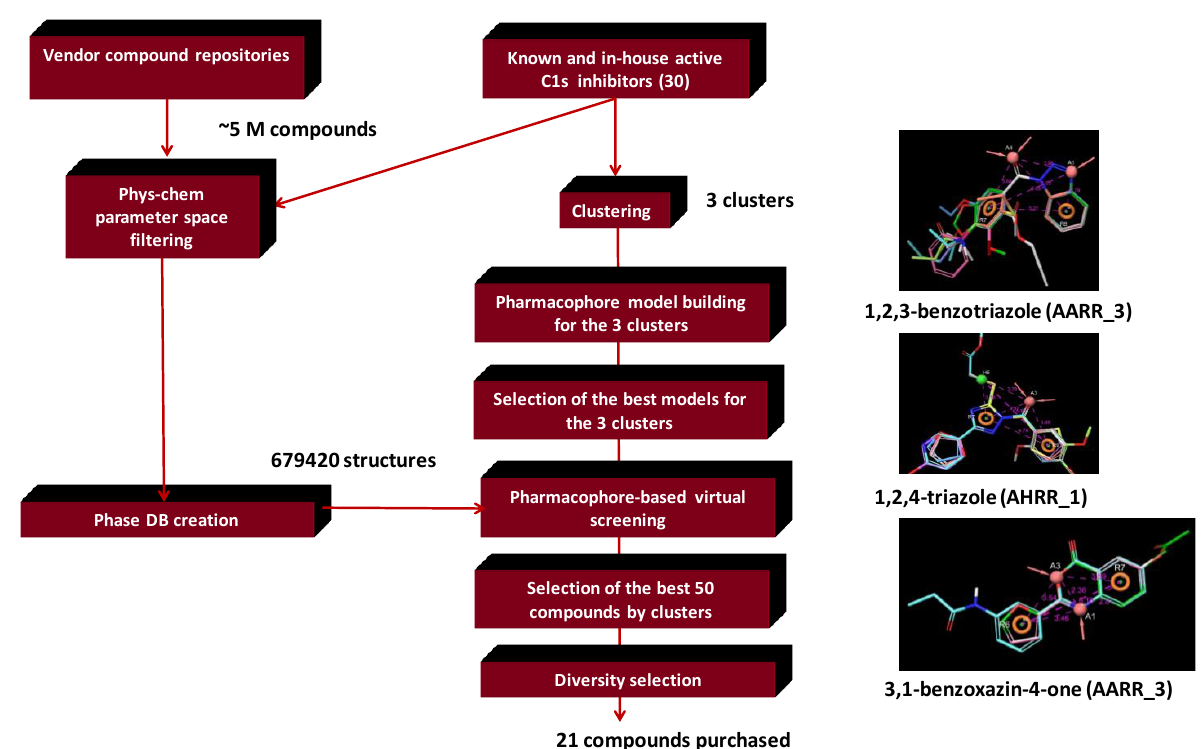
Figure 8. Pharmacophore model generation and application in sequential integration of virtual screening methods for identifying C1s inhibitors.